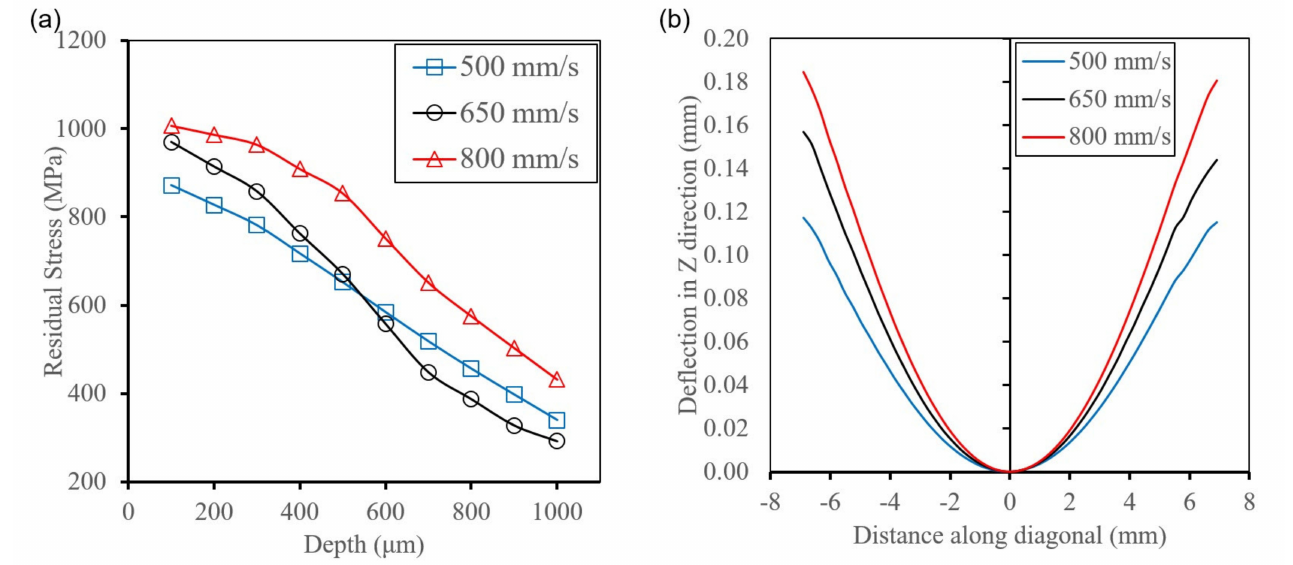
Figure 47. Effect of scan speed on ( a ) in-depth RS and ( b ) deflection in the Z direction. The deflection of the top surface in the Z direction is of particular interest, as it increases the chances of the recoater impacting the part and damaging or breaking the part off. Therefore, the deflection was extracted along the diagonal of the part, as shown in Figure 48a. It is observed that after cutting the part from the build plate, the edges of the part deflect upwards. At the same time, the center sinks in, resulting in a parabola-shaped surface.